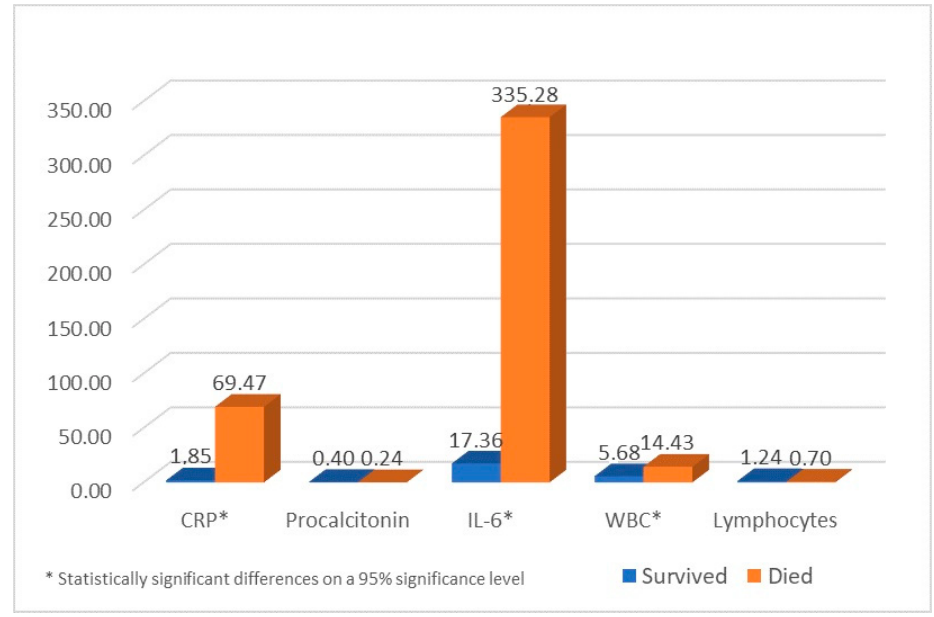
Figure 1. Average values of laboratory findings in survivors and deceased patients.